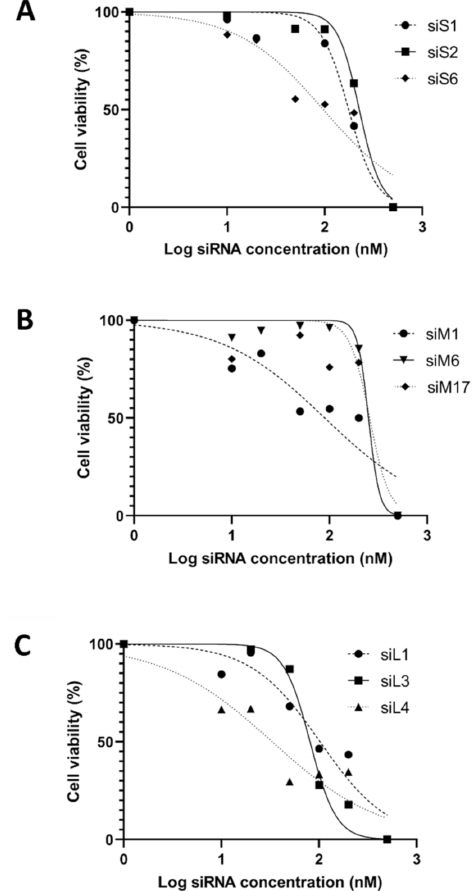
Figure 1. The graphs show cell viability assay results by GraphPadPrism software. ( A ) Represents the e ff ect of di ff erent concentrations of S segment siRNAs, ( B ) M segment siRNAs, and ( C ) the L segment siRNAs. Calculated CC50 and R squared data are represented in Table 1. The horizontal axis represents the logarithmized, di ff erent concentrations of siRNAs (nM) and the vertical axis represents the cell viability (%). Table 1. Calculated CC50 values by GraphPadPrism software during cell viability assay. siS1 siS2 siS6